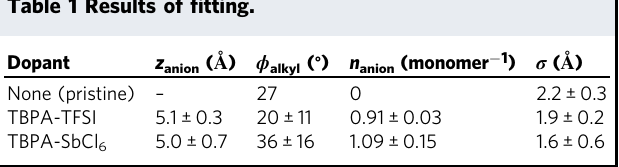
Table 1 Results of fi